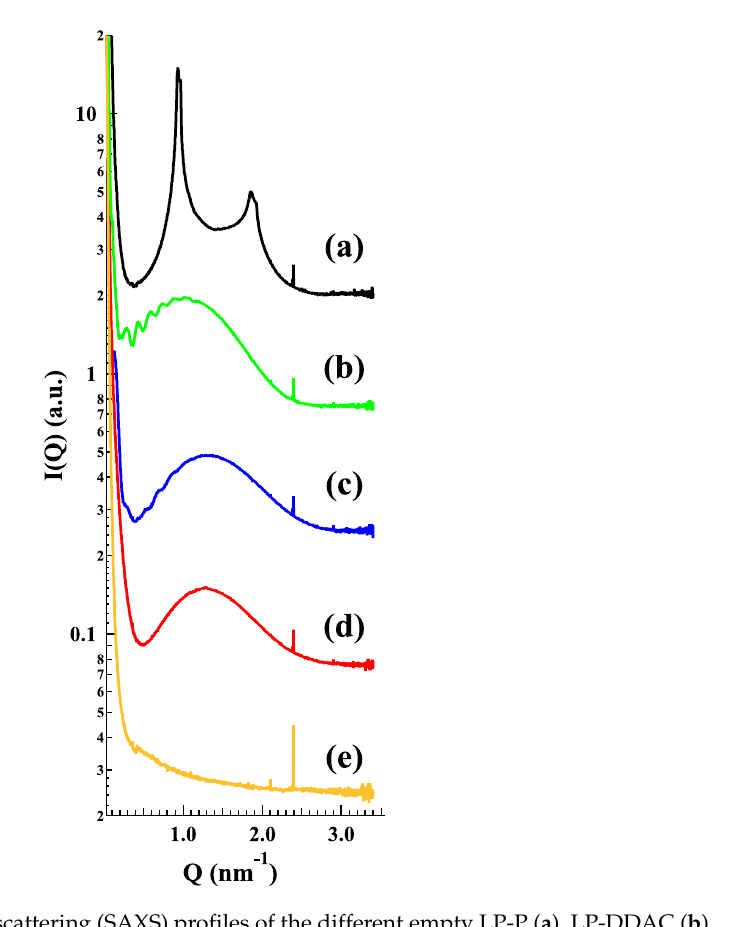
Figure 4. Small-angle X-ray scattering (SAXS) profiles of the different empty LP-P ( a ), LP-DDAC ( b ), LP-DEBDA ( c ), LP-SA ( d ) and LP-DCP ( e ). Experiments were performed at Diamond Light Source